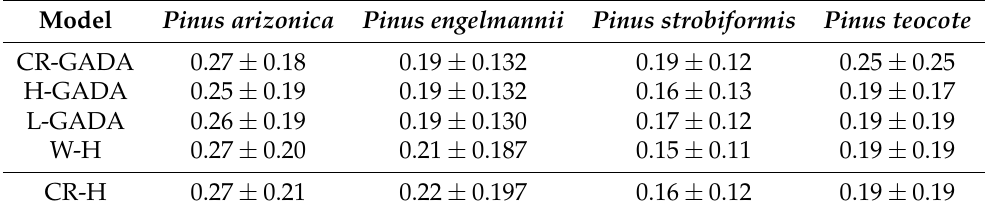
Table 5. Root Mean Square Error (RMSE) and respective standard deviation results for each species and model of the study.